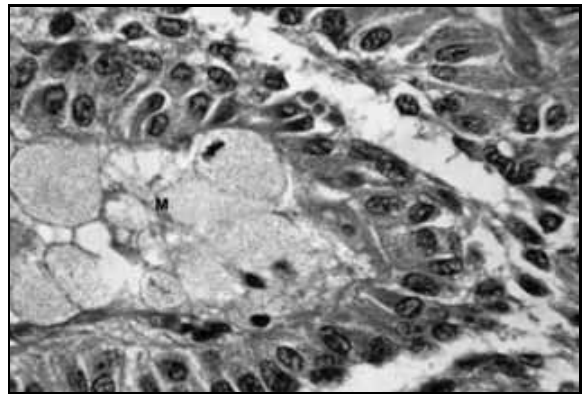
Figura 3B – TSPPP com arranjo papilar contendo macrófagos (M) no eixo conjuntivo central e revestimento por células cilíndricas, citoplasma mediano e núcleos regulares (HE, 400x)